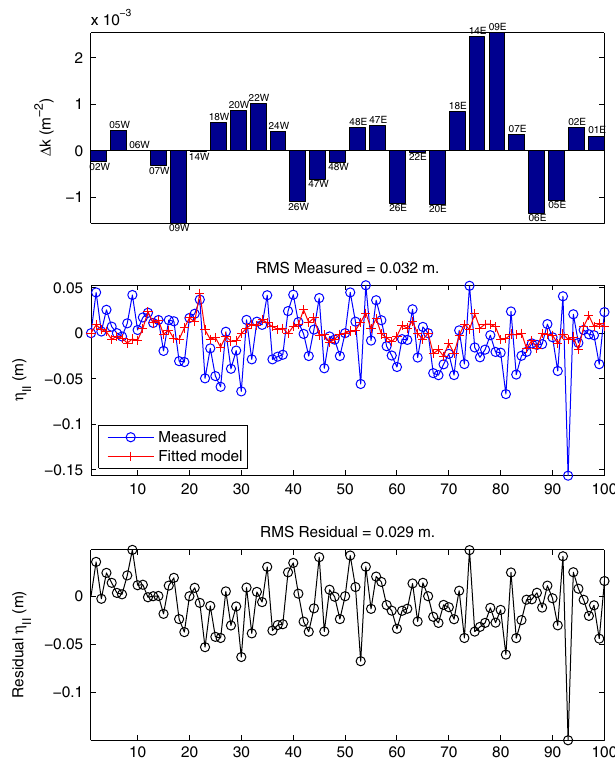
FIG. 14. Results of fitting a model to a measurement of the mode II dispersion. The measurement was made after all skew quadrupoles were turned off, following an initial low-emittance tuning using conventional techniques (vertical orbit and disper- sion correction, and coupling correction). Top: fitted skew quad- rupole strengths. Middle: measured and fitted mode II dispersion. Bottom: residual between measured and fitted mode II dispersion. Note that in this case, a poor fit is achieved in the model to the mode II dispersion. This suggests that the skew quadrupoles would not be effective in correcting the real sources of mode II dispersion in the